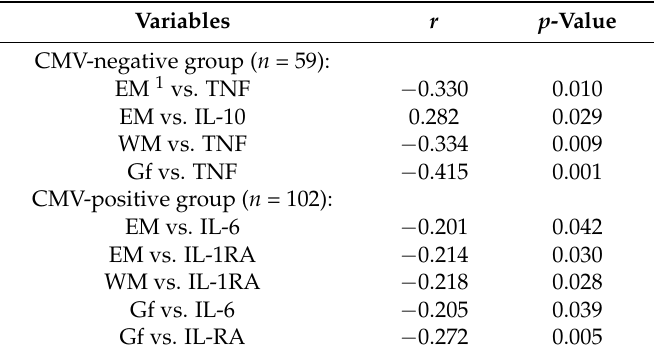
Table 1. Pearson’s correlation coefficients ( r ) and corresponding p -values for associations between cognitive performance scores and circulating peripheral inflammatory